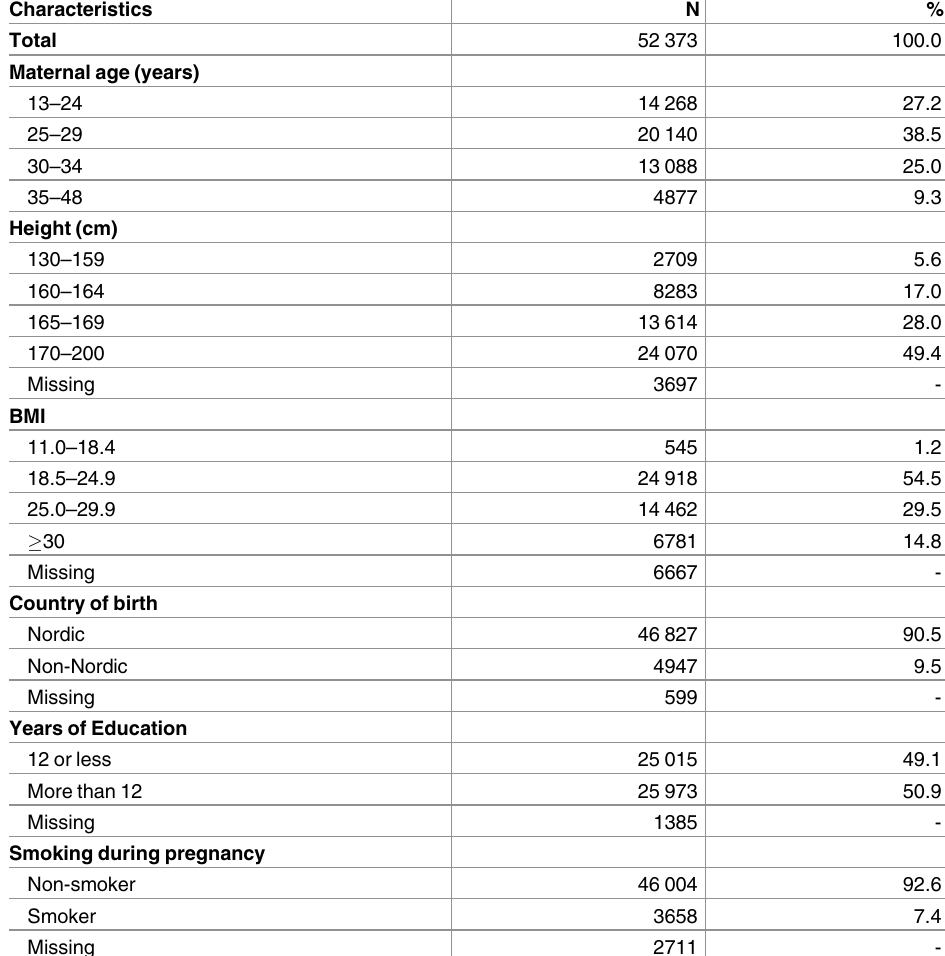
Table 1. Maternal and delivery characteristics in singleton births at 38 gestational weeks and onward with birthweight for gestational age above the 90 th percentile in primiparous women, Sweden, 1992–